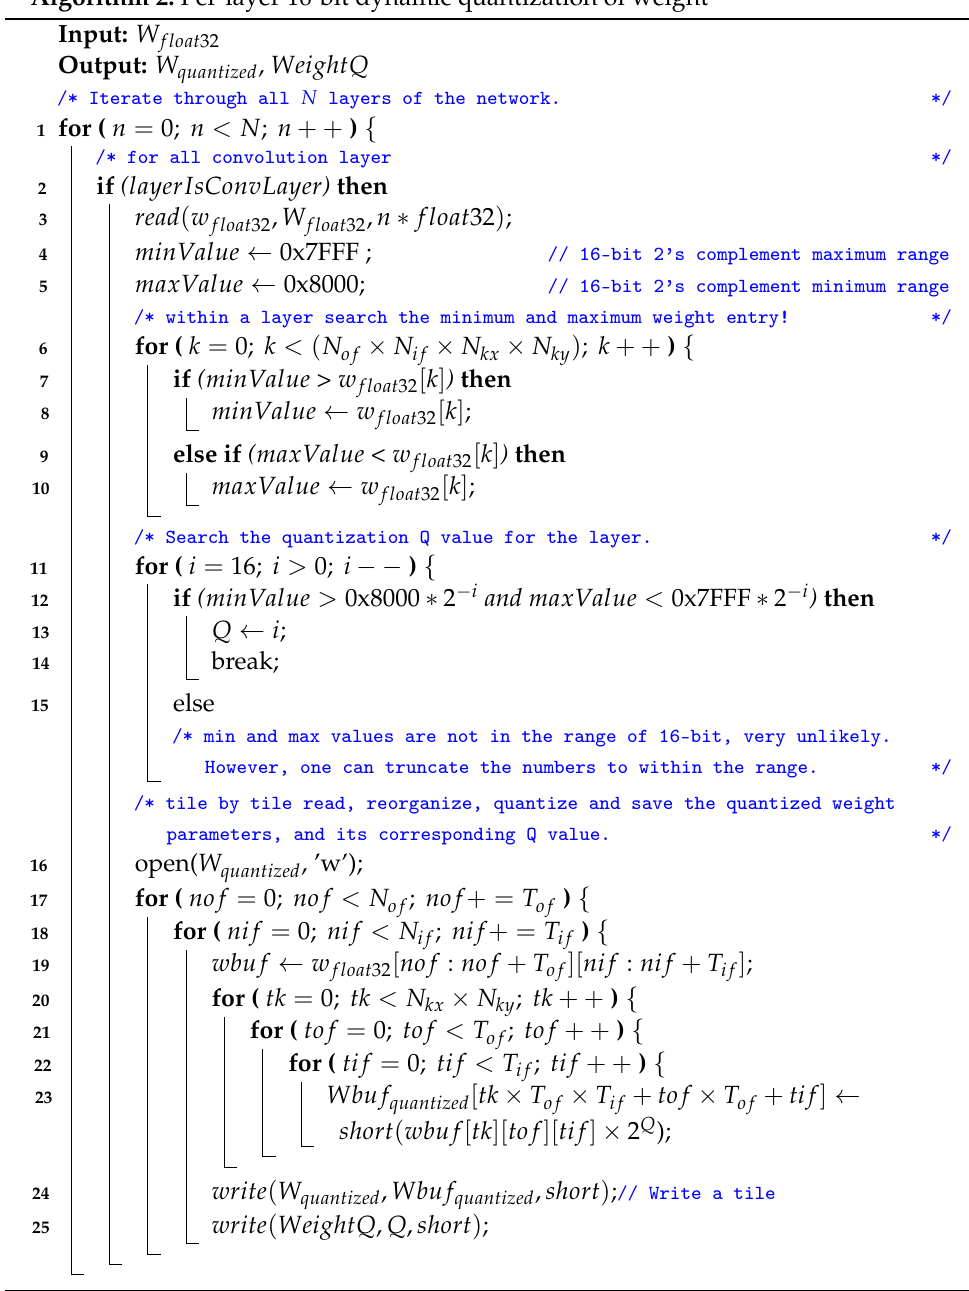
Algorithm 2: Per-layer 16-bit dynamic quantization of